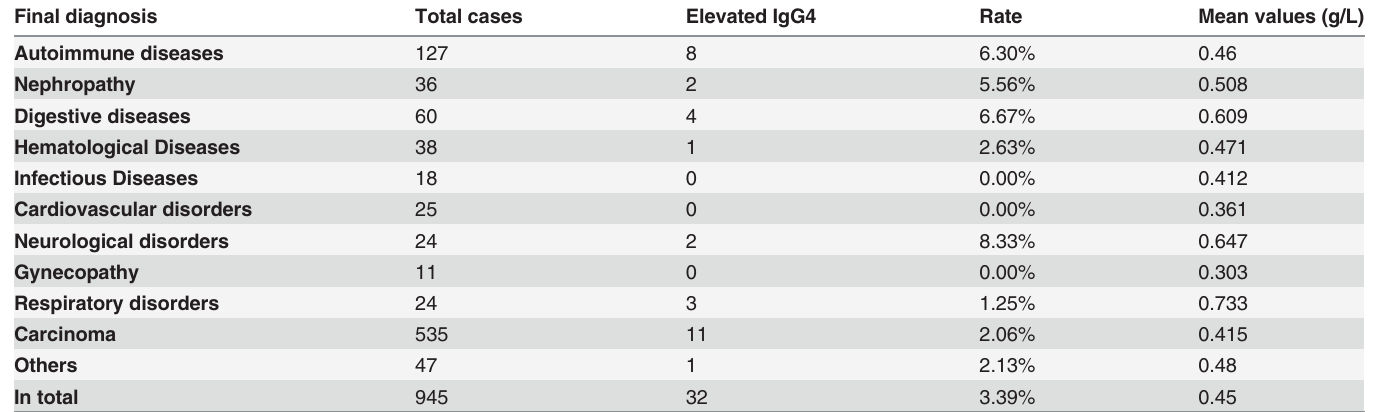
Table 1. Patients with elevated levels of serum IgG4 (measured by ELISA).